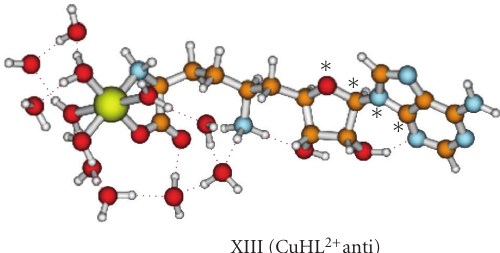
Figure 7: The lowest energy structure of CuHL 2+ complex. The ro- tation angle of adenine is marked with